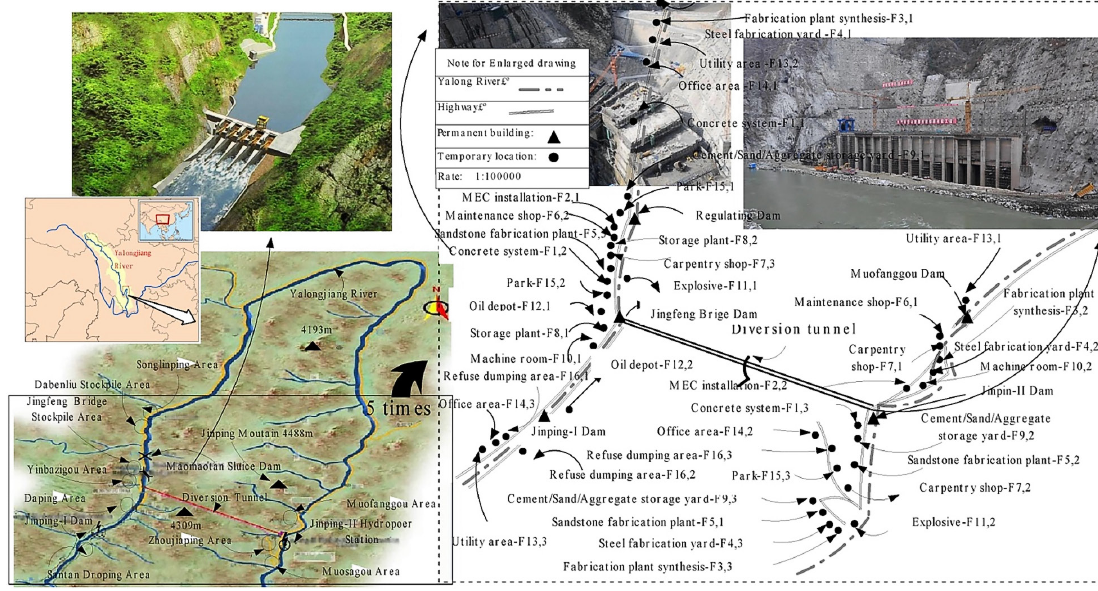
Fig. 5. The map of Jinping II hydropower